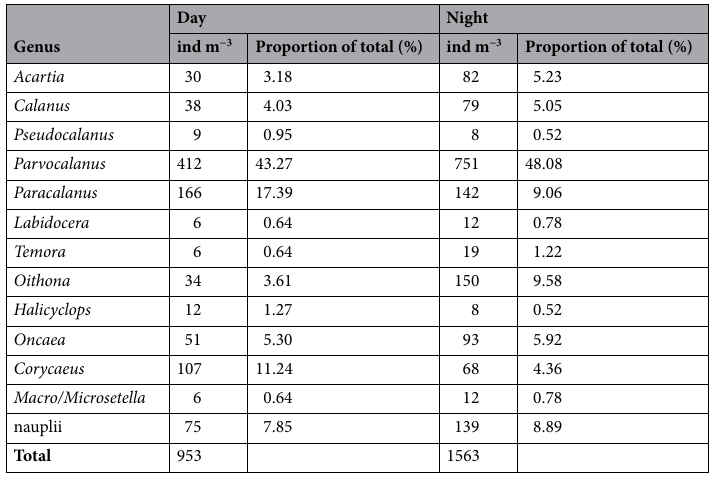
Table 2. Estimates of number of each species found in situ and their proportions of the total copepod population. All species observed were found in both day and night samples.